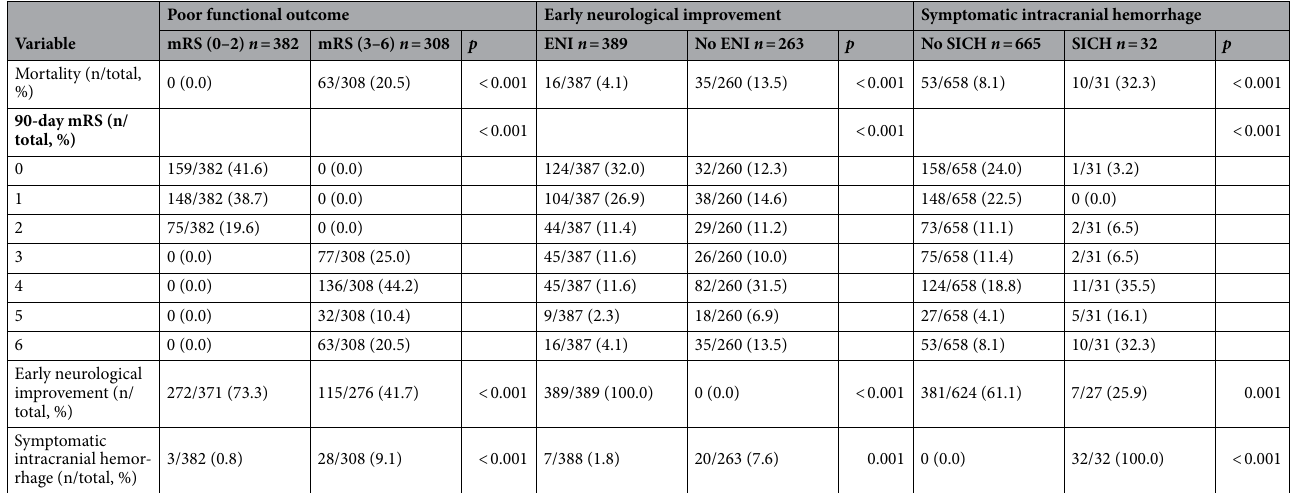
Table 2. Comparison between patients stratified by poor functional outcome, early neurological improvement and symptomatic intracranial hemorrhage. n number, total number of non-missing values of each variable, p p-value of Pearson’s Chi-squared test for categorical variables and Mann–Whitney U test for continuous variables, IQR interquartile range, mRS modified Rankin scale, mmol/L millimoles per liter, min minutes,